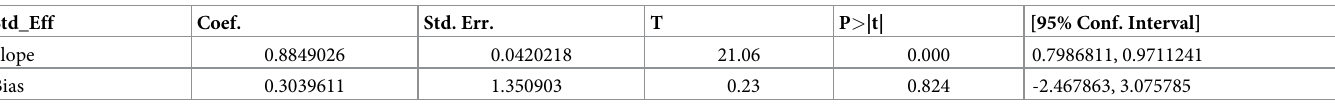
Table 4. Egger’s test of publication bias for the pooled MD estimate of MPV between PE and NT groups. Std_Eff Coef. Std. Err. T P > |t| [95% Conf. Interval]